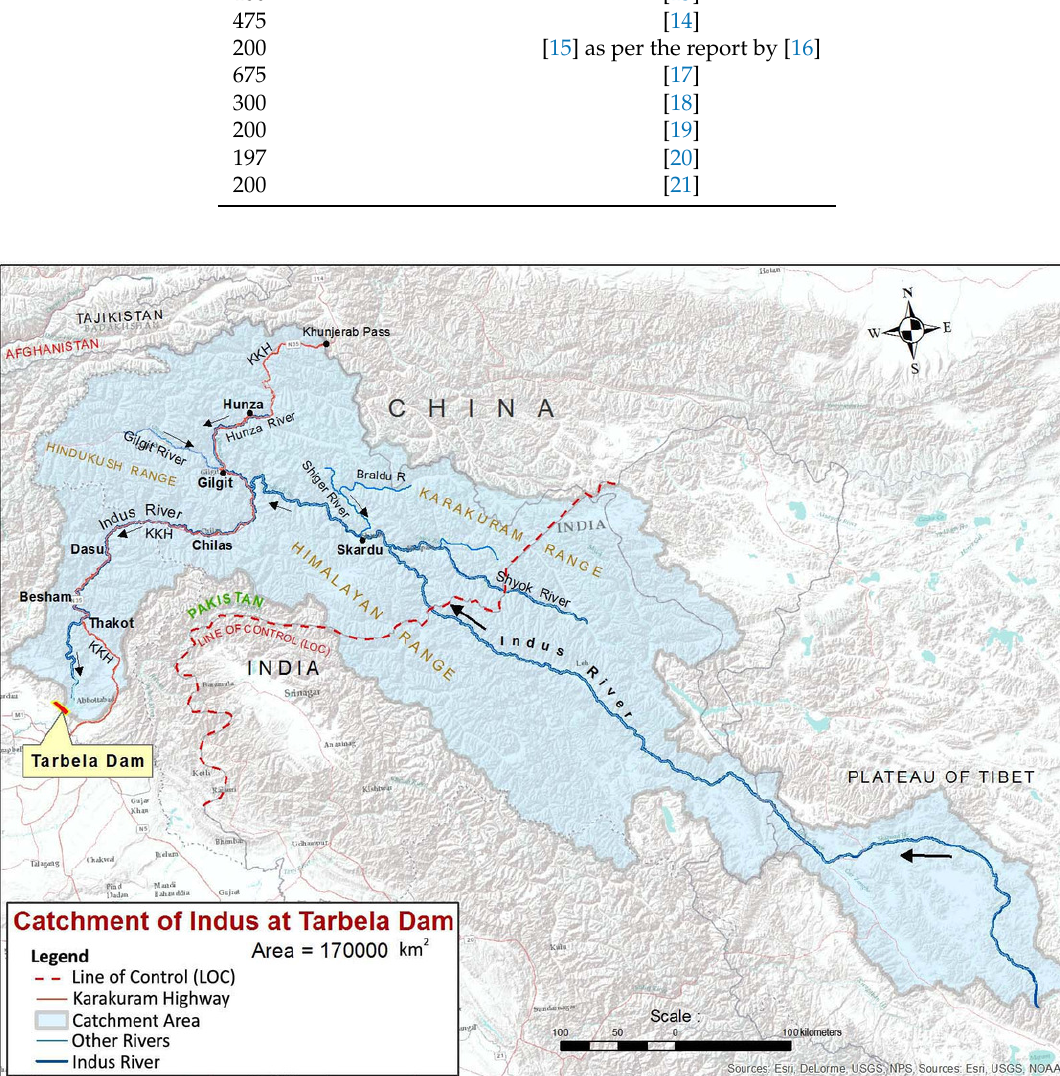
Figure 1. Demarcated Upper Indus Basin at Tarbela